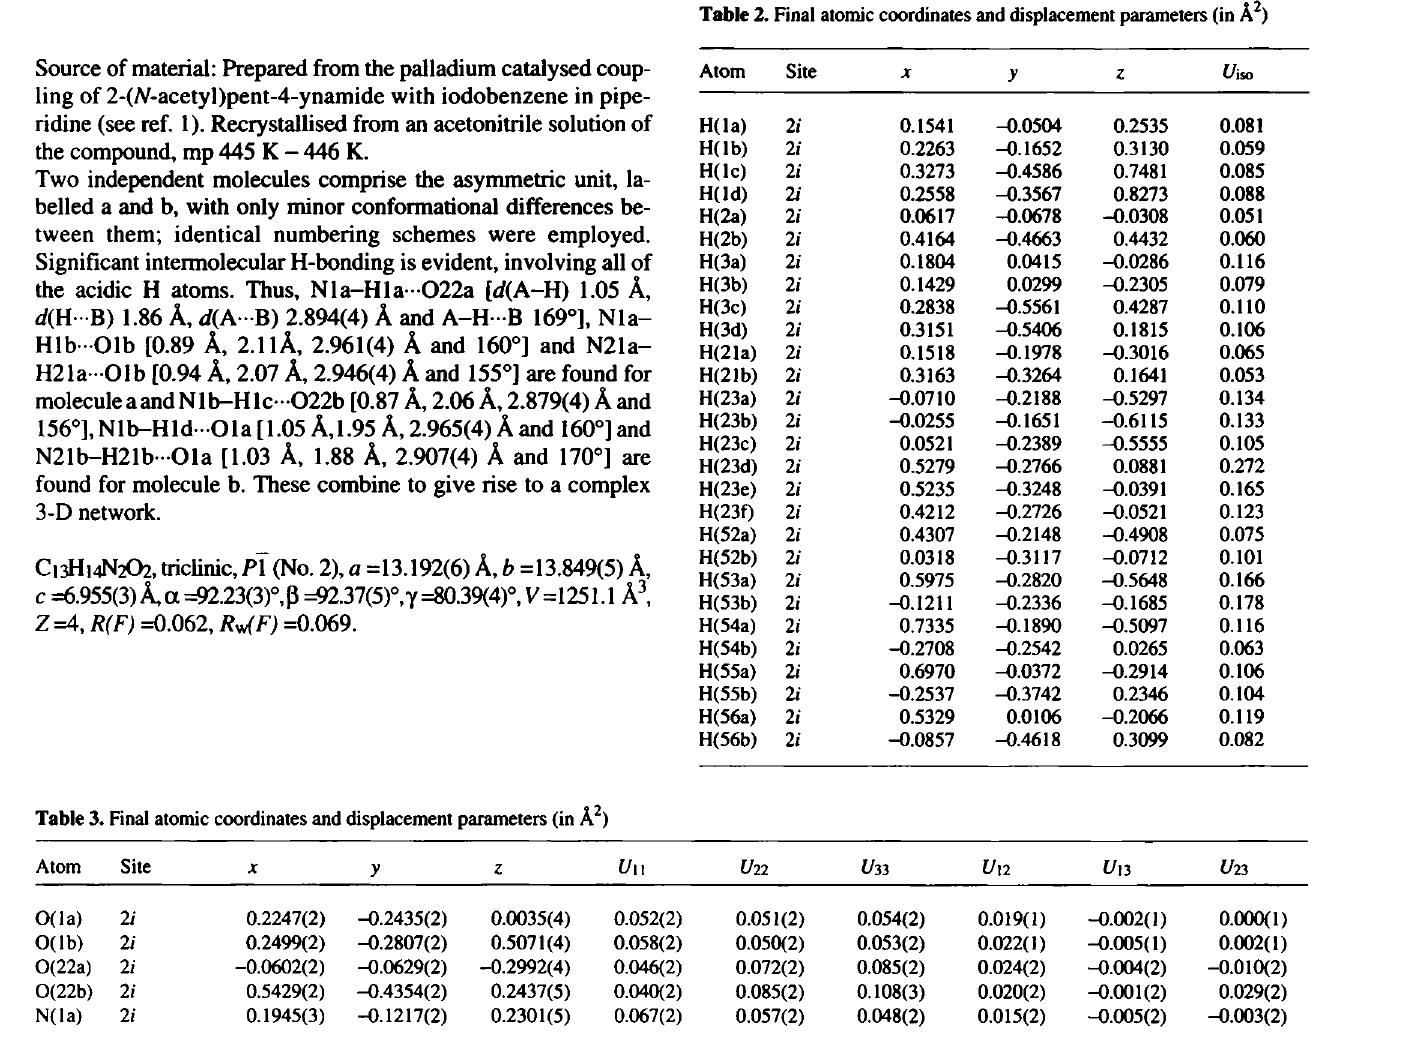
Table 2. Final atomic coordinates and displacement parameters (in Â^)